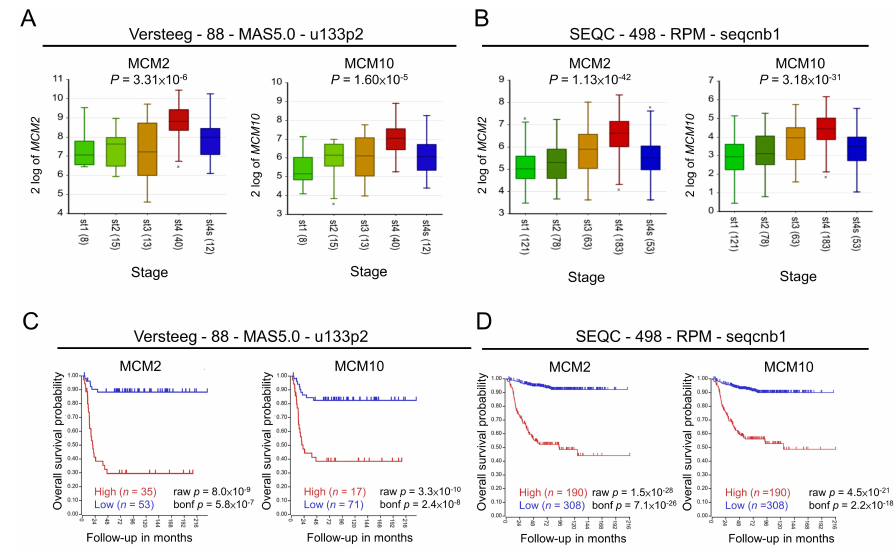
Figure 1. Expression of MCM complex genes across INSS stages and their association with survival probability: ( A , B ) Boxplots of MCM2 and MCM10 expression with respective to different INSS stages from two data sets. The expression of MCM2 and MCM10 was relatively low in patients with stage 4S neuroblastoma, in accordance with better prognosis associated with this stage of disease. The x -axis represents the INSS stage with patient numbers shown in parentheses. p -values were computed using one-way ANOVA. The “x value” is indicated as the outlier. ( C , D ) Kaplan–Meier curve analysis of patients with neuroblastoma stratified by MCM2 or MCM10 expression ( n = 88 and n = 498 samples in each data set). High and low expression of a given gene was shown as red and blue, respectively. INSS, International Neuroblastoma Staging System. p -values were computed using log-rank test (raw p ) and then corrected with the Bonferroni method (bond p